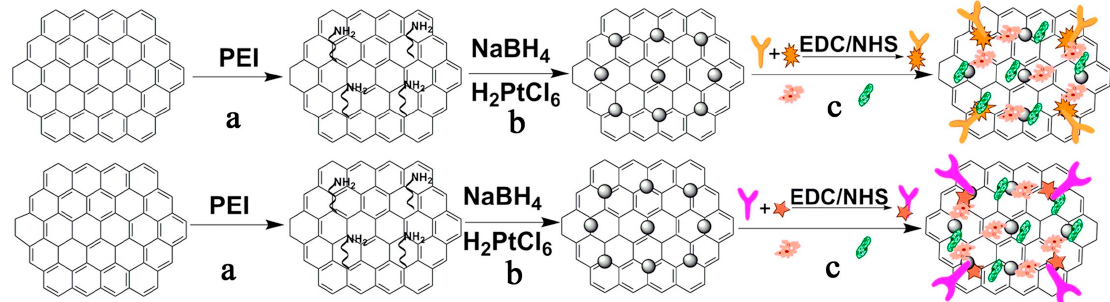
Figure 9. Preparation procedure of PGN-Ab1/2 probes: (a) modification with PEI to obtain active groups of amino; (b) reducing H 2 PtCl 6 to form PtNPs; (c) labeling PGN with thionine-anti-CEA, ferrocene-anti-AFP, HRP and GOD. Reproduced with permission from [48].